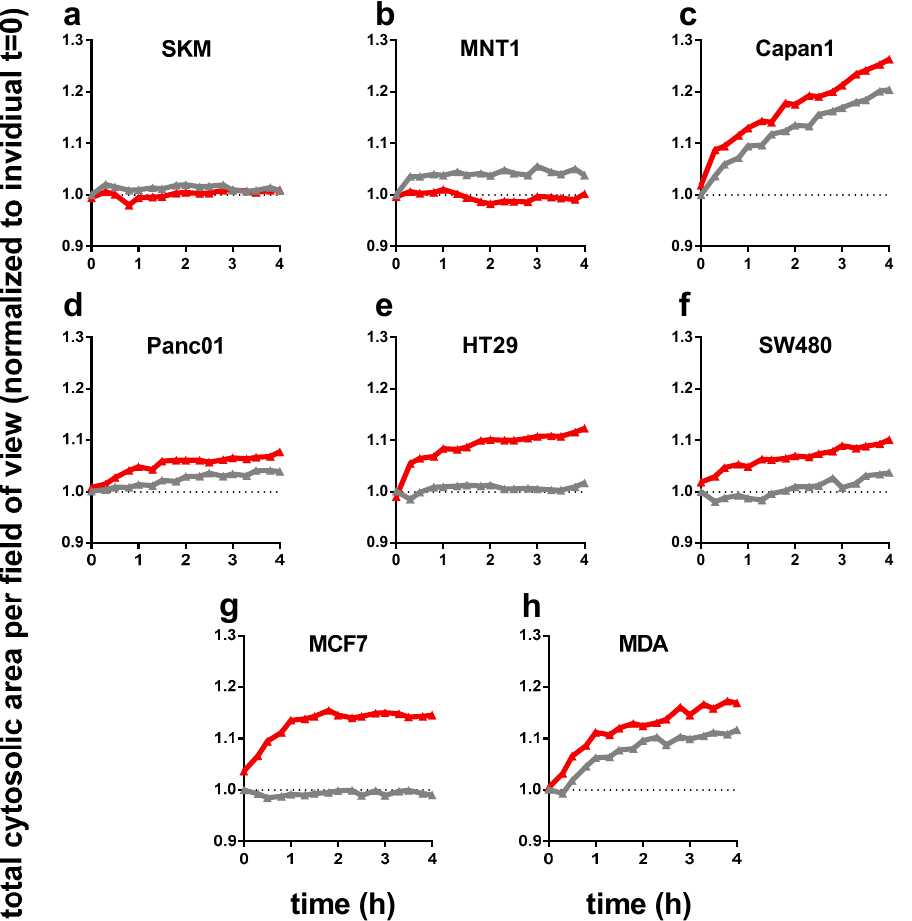
Figure 2. The total cytosolic cell growth area significantly increased with PTM (red) in six out of eight tumor cell lines (in 96-well plates with 1 × 10 4 cells initially seeded). Time-dynamic data are from high-content microscopy in digital phase contrast mode (indicating cytosolic area, see materials and methods Section 2.3) and summarize data from over 20,000 single images. ( a ) SK-Mel 28, ( b ) MNT-1, ( c ) Capan 1, ( d ) Panc 01, ( e ) HT 29, ( f ) SW 480, ( g ) MCF7, and ( h ) MDA-MB-231; untreated medium control and PTM were normalized to each t = 0. Data are from three independent experiments with four technical replicates each. PTM = plasma-treated medium (red lines); control = untreated medium (grey lines).